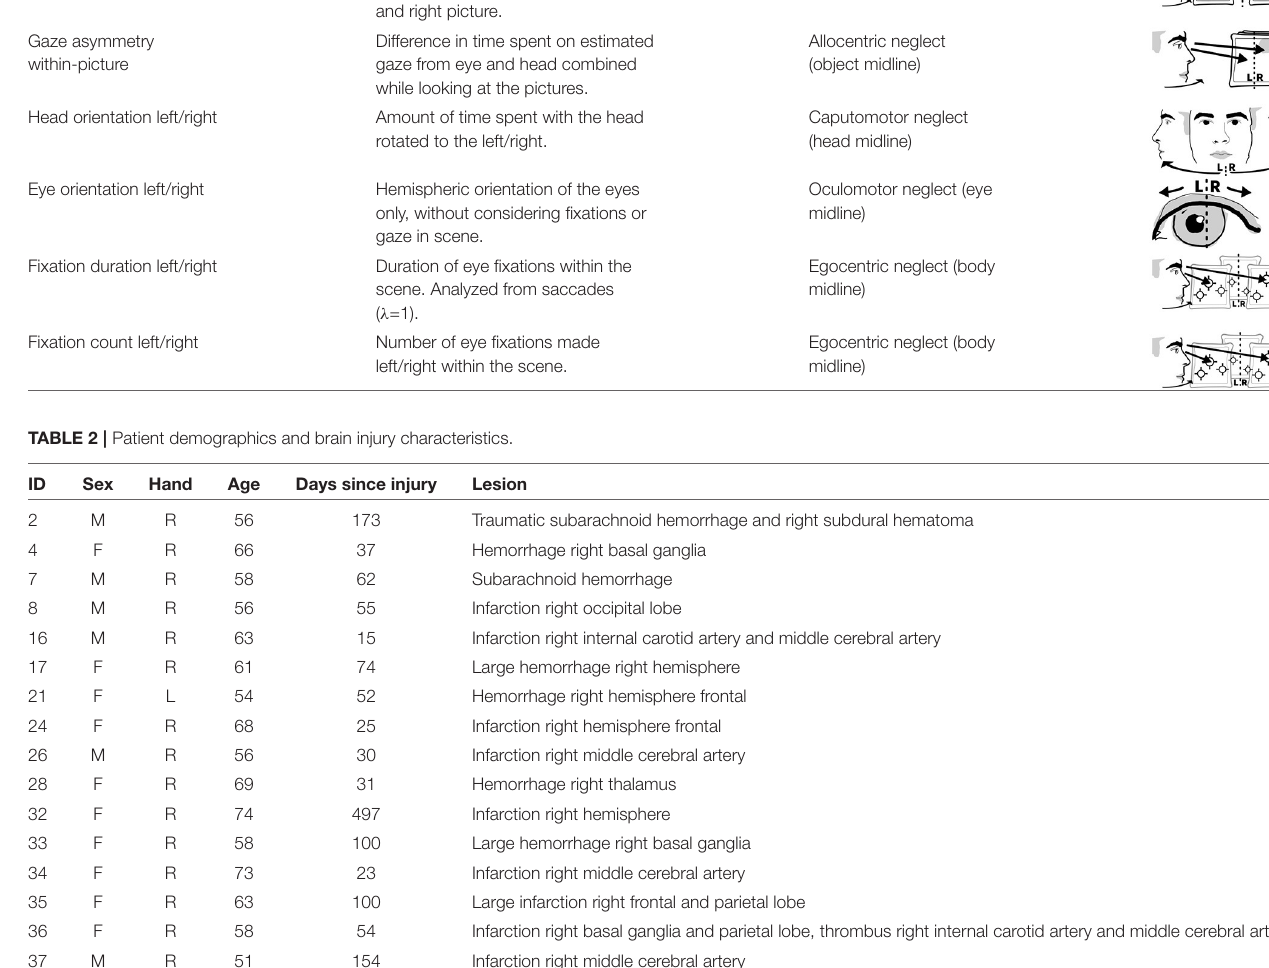
Eye tracking data was filtered to include only data points from looking at the three pictures. Gaze asymmetry measured the position of the participants’ gaze projected onto these pictures. Between picture gaze asymmetry left out eye tracking data from the middle picture and subtracted the amount of time spent looking at the left-most picture from the time looking at the right-most picture. These temporal aggregates were solely based on the number of eye tracking samples located on each respective picture. Their fixation counts and the totalled duration of the fixations were separate measures. Within-picture gaze asymmetry divided each picture into a left and right section and compared the participants’ time spent gazing on each side, to measure allocentric